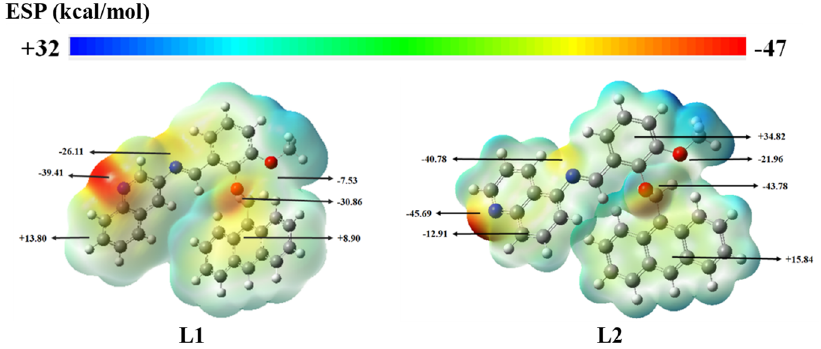
Figure 10 . Electrostatic potential maps with the approximate potentials (in kcal/mol) across the marked regions.